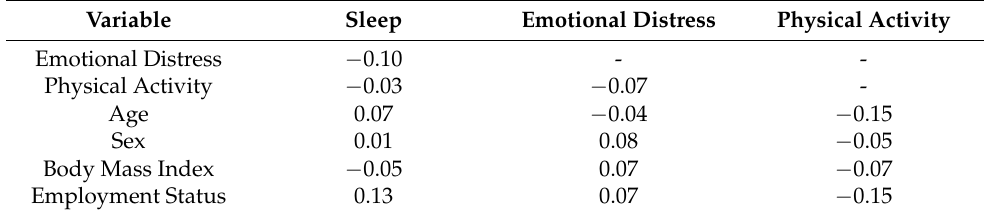
Table 2. Bivariate correlations matrix between relevant variables of interest and covariates ( n = 274,041).